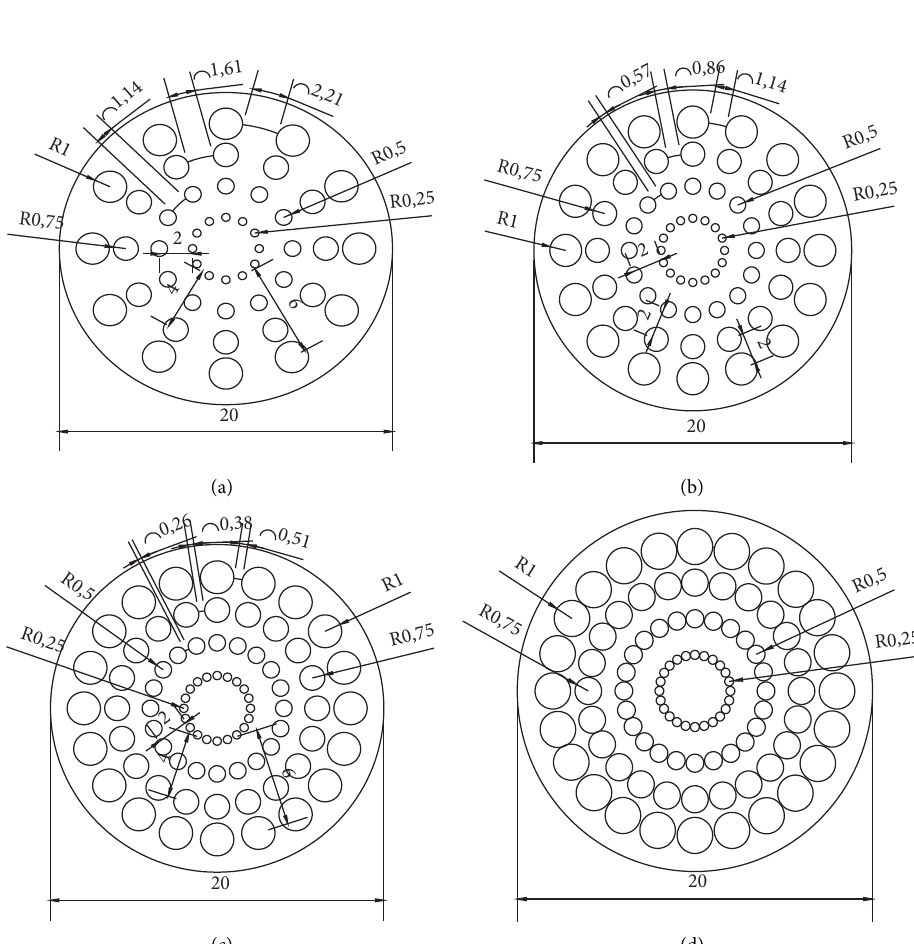
Figure 2: Different types of distribution board; adjust the opening rate separately: (a) 22.5%, (b) 30.0%, (c) 37.5%, and (d)